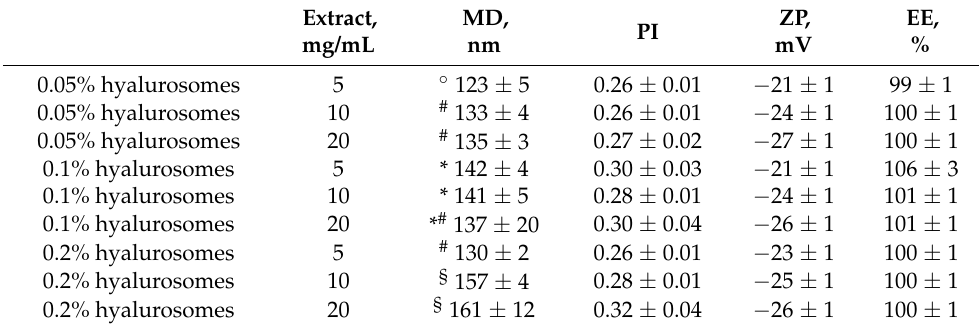
Table 2. Mean diameter (MD); polydispersity index (PI); zeta potential (ZP); entrapment efficiency (EE) and Trolox equivalents (TE). Mean values ± standard deviations are reported ( n = 6). Same symbol (*, ◦ , § , # ) indicates the same value ( p > 0.05). Extract, MD, ZP, EE, PI mg/mL nm mV % 0.05% hyalurosomes ◦ 123 ± 5 0.26 ± 0.01